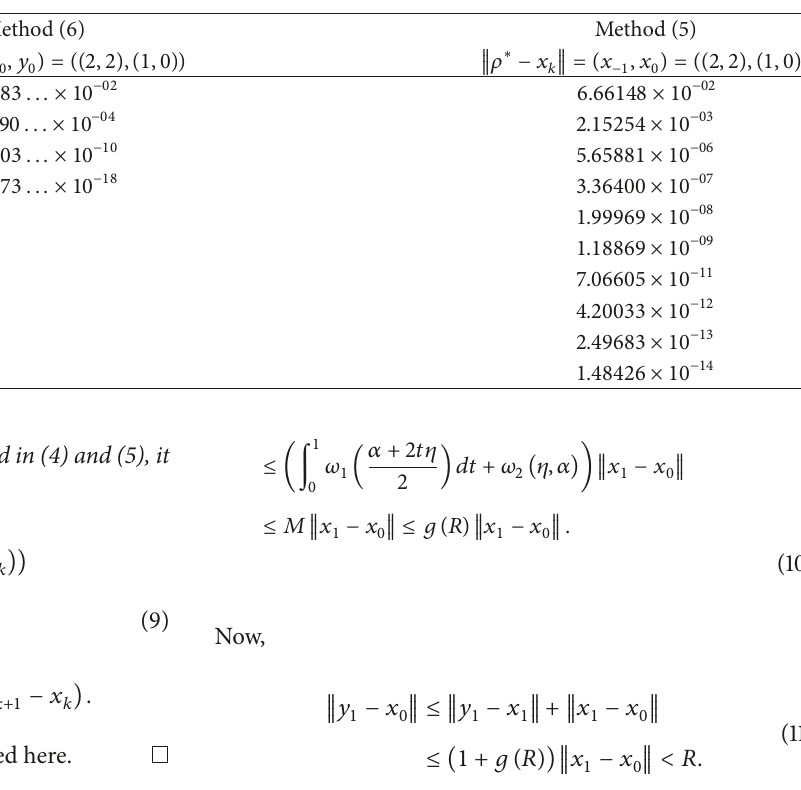
Table 1: Comparison of absolute